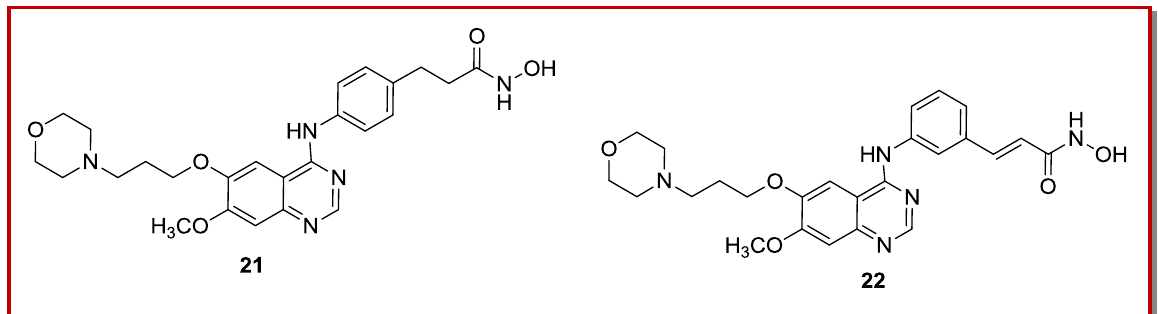
Figure 11: Some quinazoline motifs which served as HDAC